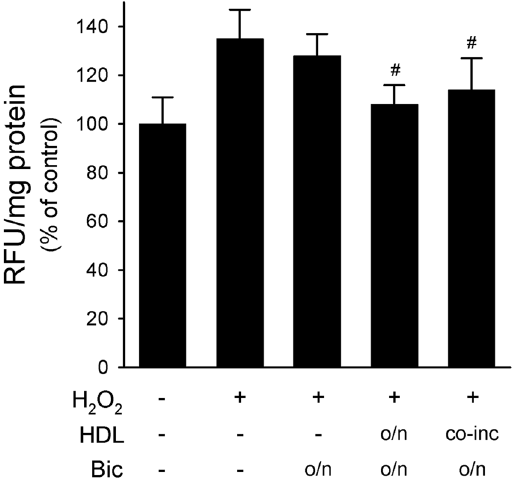
Figure 2. AR activation is not involved in HDL antioxidant effect. LNCaP were treated overnight (o/n) with the androgen receptor antagonist bicalutamide (100 nM) before stimulation with 0.5 mM H 2 O 2 for 1 h. HDL at 0.5 mg/ml were given overnight or as co-incubation with H 2 O 2 (co-inc) for 1 h. ROS production was evaluated by fluorescence. Data are expressed as relative fluorescent units (RFU) normalized by the protein concentration of total cell lysate, mean ± SD, n = 6. # P < 0.05 vs H 2 O 2 -stimulated